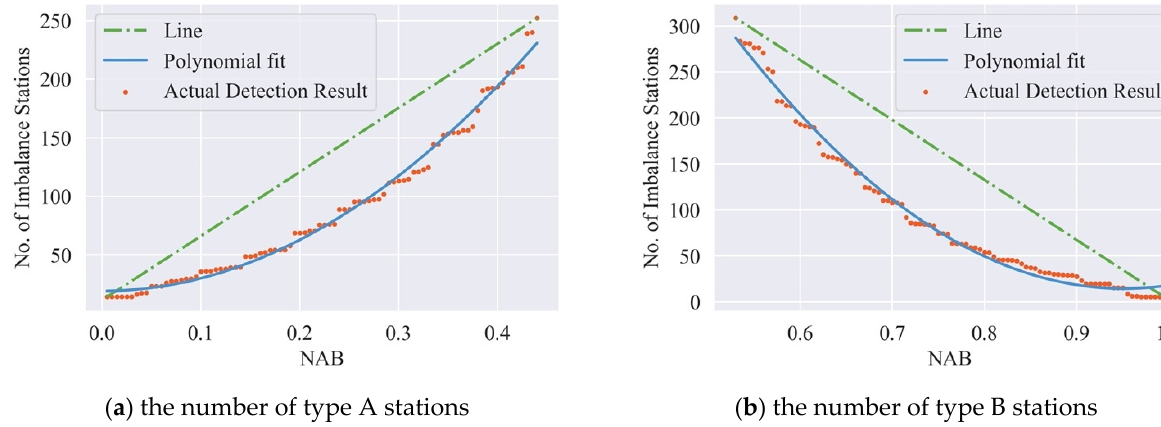
Figure 4. Sensitive analysis on imbalance usage detection. Fit results on the number of ( a ) type A and ( b ) type B stations. Thus, we used 𝑎 = 0.25 and 𝑏 = 0.74 in the imbalance-usage detection process to find problematic stations, and results are shown in Figure 5. The blue line (Type A) represents the number of docking stations with NABs less than 0.25, while the red line (Type B) represents the ones with a NABs greater than 0.74.